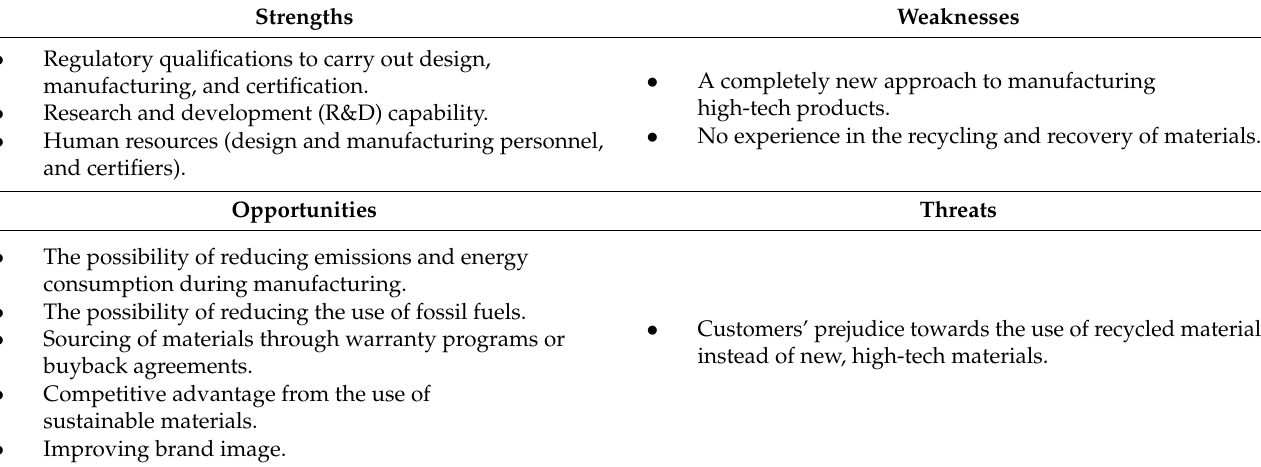
Table 1. SWOT analysis of an OEM manufacturer of recycled material